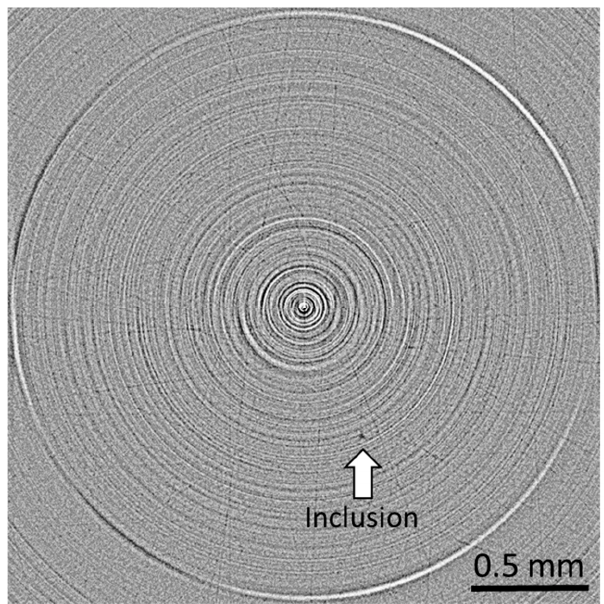
Figure 6. Example of the reconstructed image of a cross section. Metals 2019 , 9 , x FOR PEER REVIEW